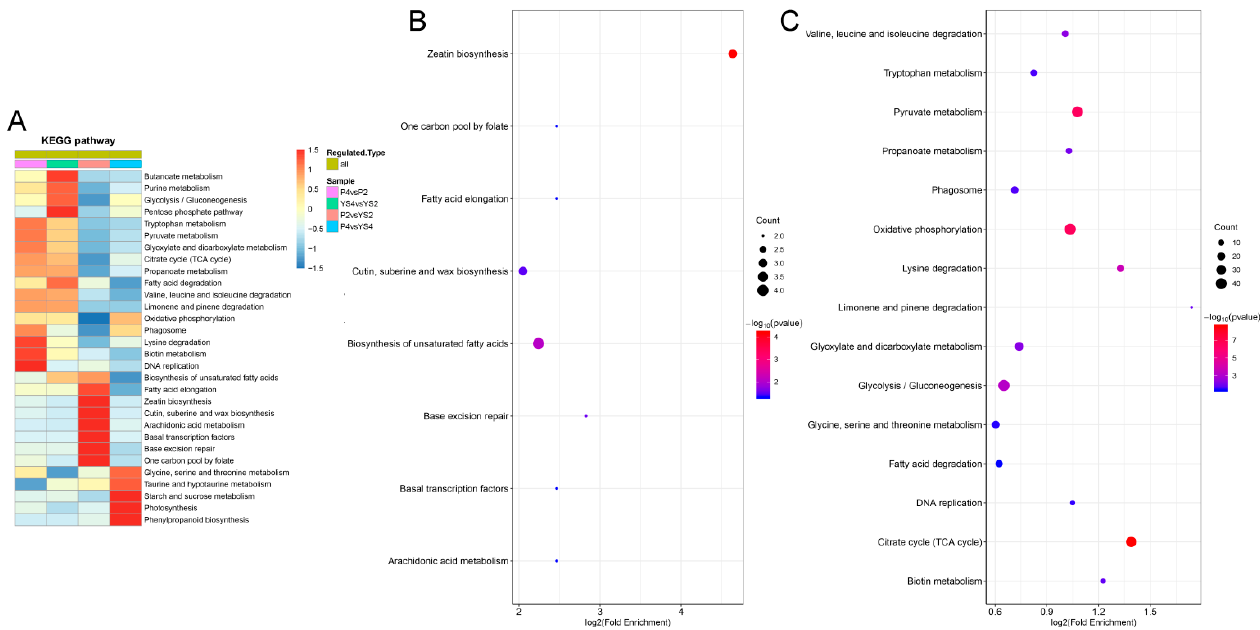
Figure 9. Enrichment analysis of DEPs. ( A ) Heatmap for cluster analysis of the KEGG pathway enrichment. ( B ) KEGG pathway enrichment of the comparison group P2 vs. Y2. ( C ) KEGG pathway enrichment of the comparison group P4 vs. Y4.